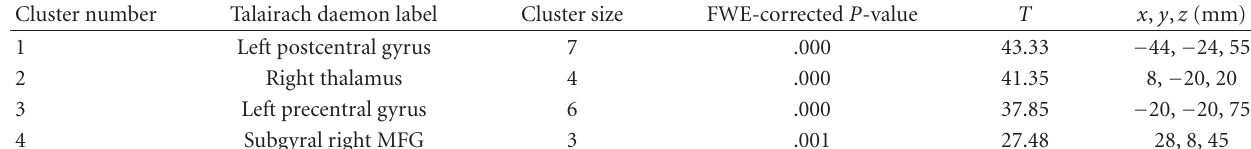
Table 1: SPM volume summary